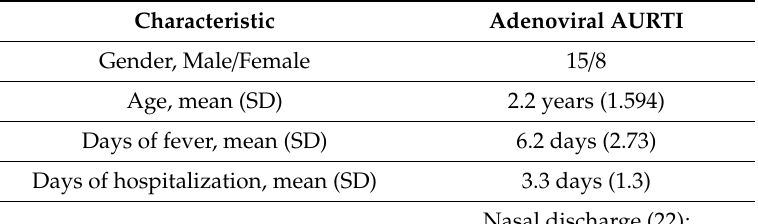
Table 2. Demographic and clinical characteristics of the